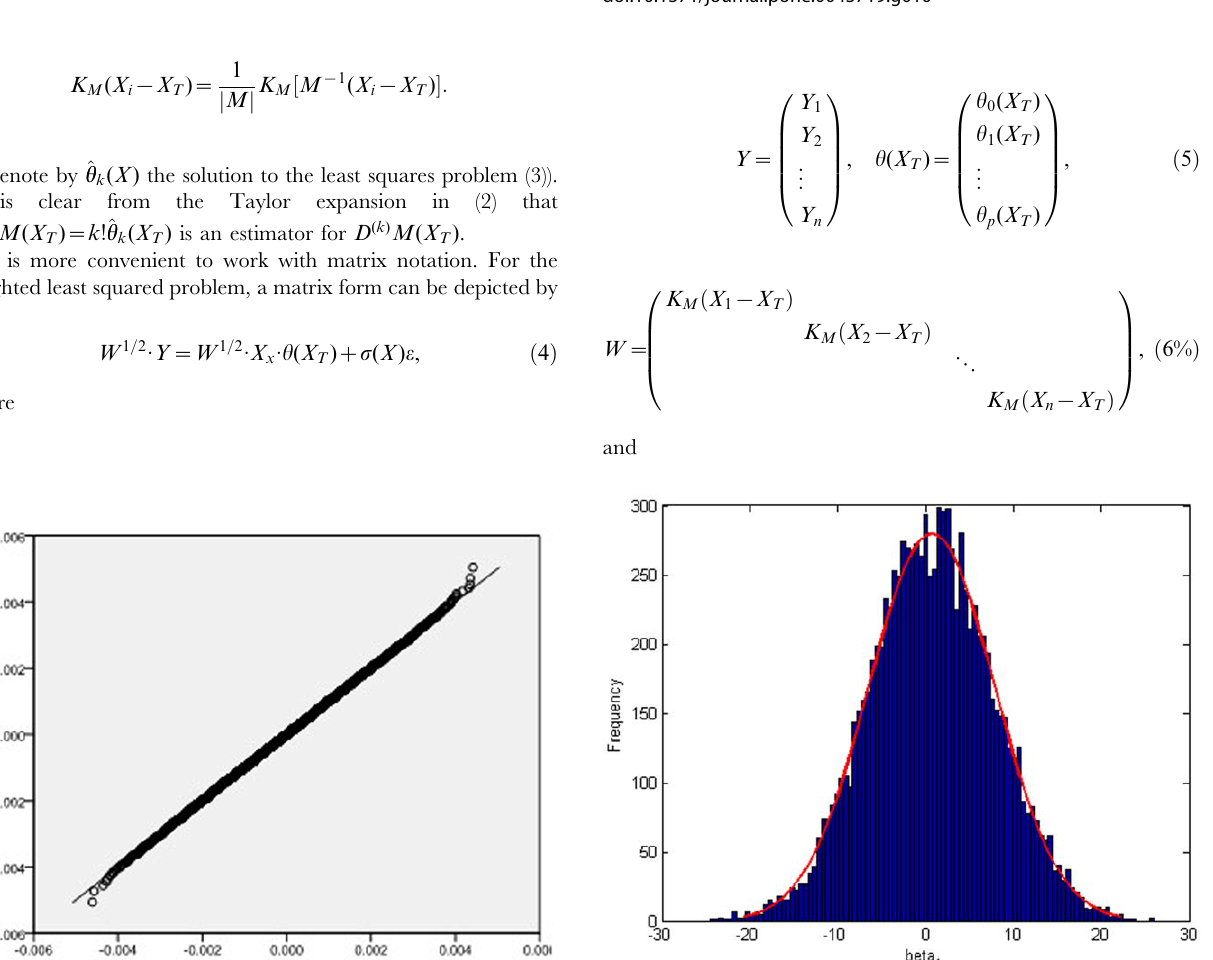
Figure 10. Histogram and asymptotic distribution for ^ bb 0 of OLS when the variance function of the error term is s 2 ( x 1 , x 2 ) ~ exp ( { ( x 1 z x 2 )) .